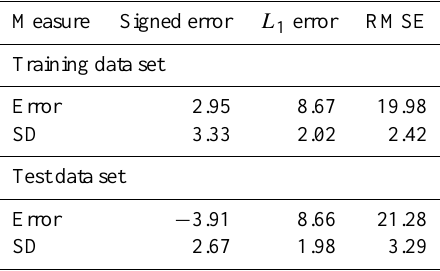
Table 1. Errors for our algorithm results compared to FMI ice charts for the training and test data sets. The latitude range of the area is 56–66 ◦ N and the longitude range 16–31 ◦ E; the results were com- puted for data rectified to Mercator projection with a resolution of 500m. For both the data sets (training and test sets) the number of scenes N = 10.